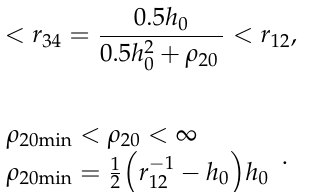
ρ ρ r h , 10 , min20 ) versus 0 .